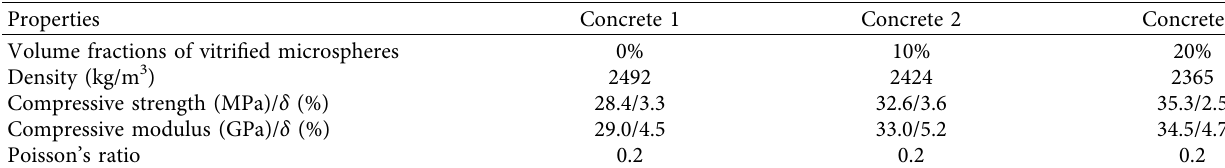
Table 2: Concrete compressive properties.